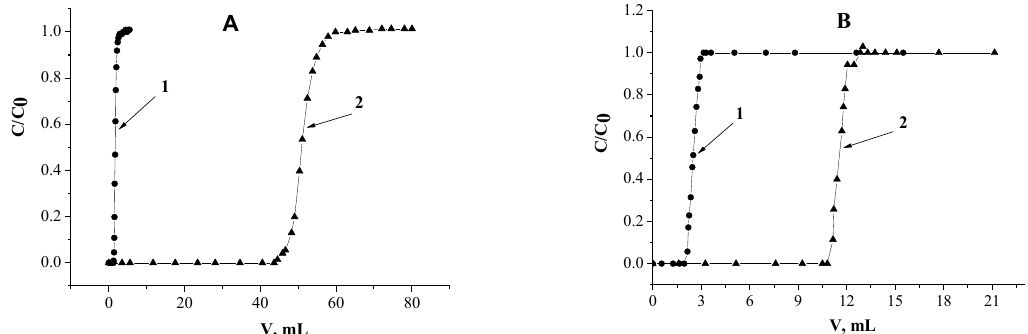
Figure 4. Influence of Nd(III) concentration in the eluent on its adsorption and the values of synergy effect. 1 –SIR 10; 2 –SIR 4. The values of Nd(III) concentration are equal 15 and 150 mg/L for experiments ( A , B ), respectively.